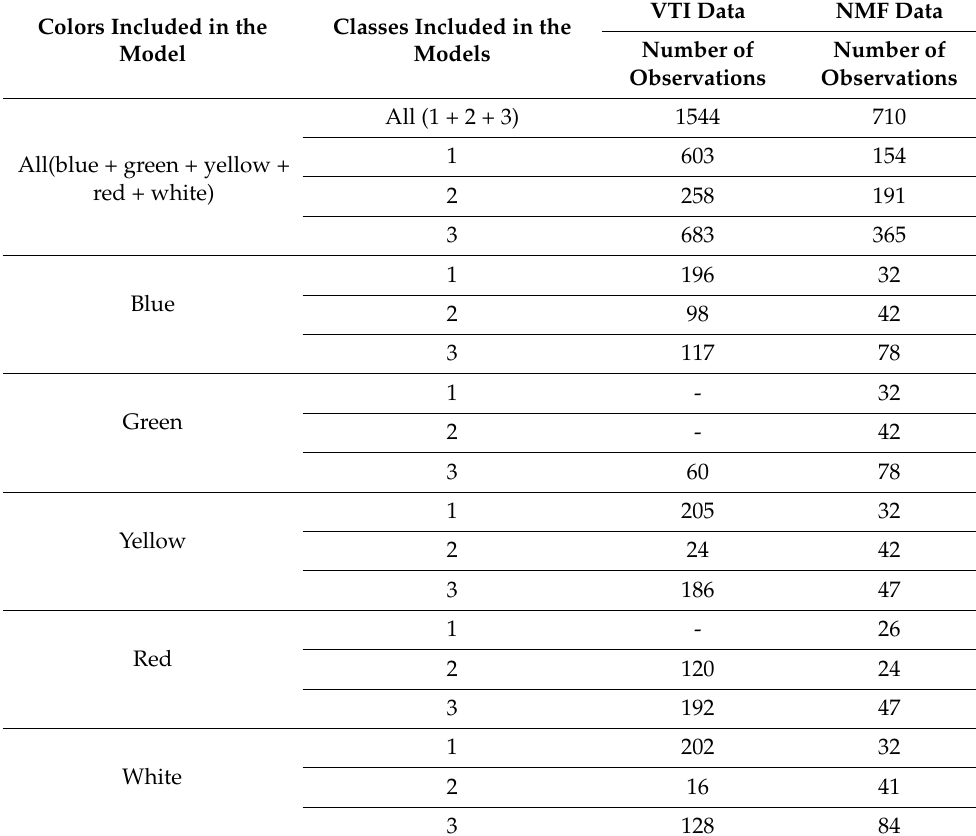
Table 10. The number of observations for divided data. Colors Included in the Model